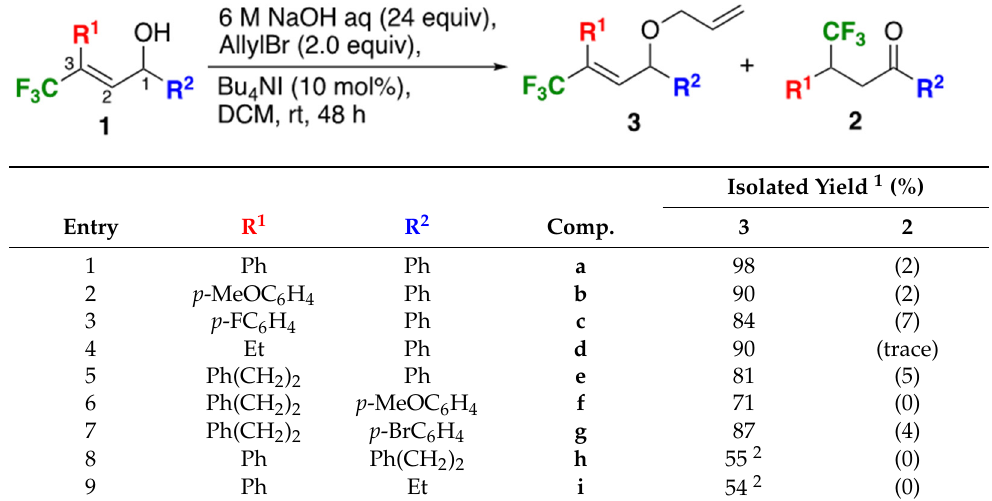
Table 2. Formation of bisallylic ethers 3 .